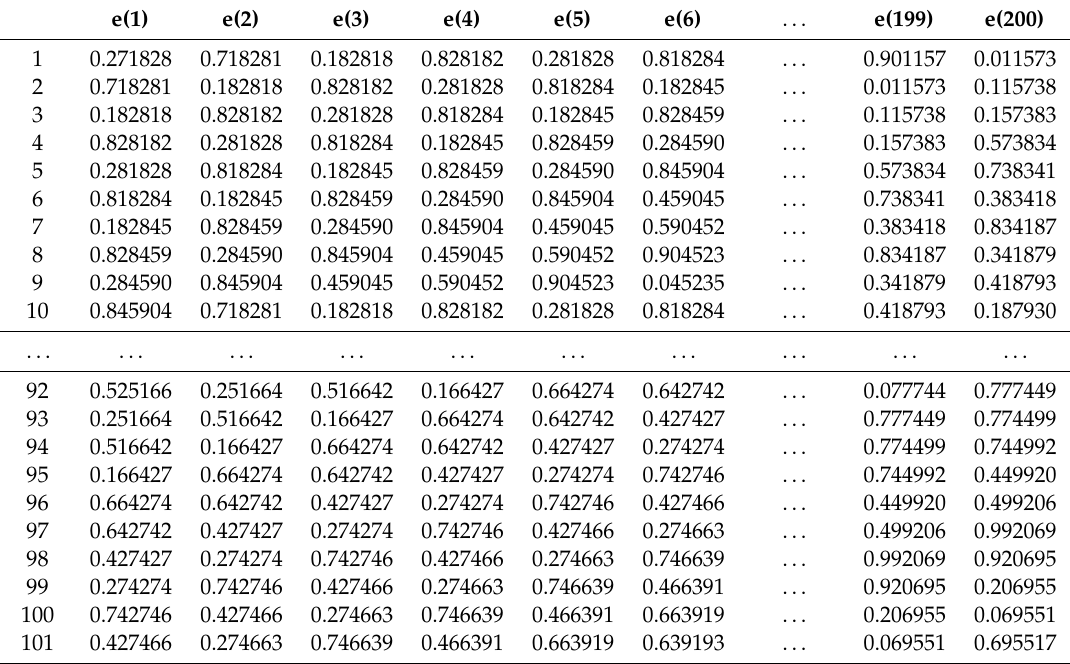
Table 2. Two hundred sets of random numbers e( i ), i ∈ [1,